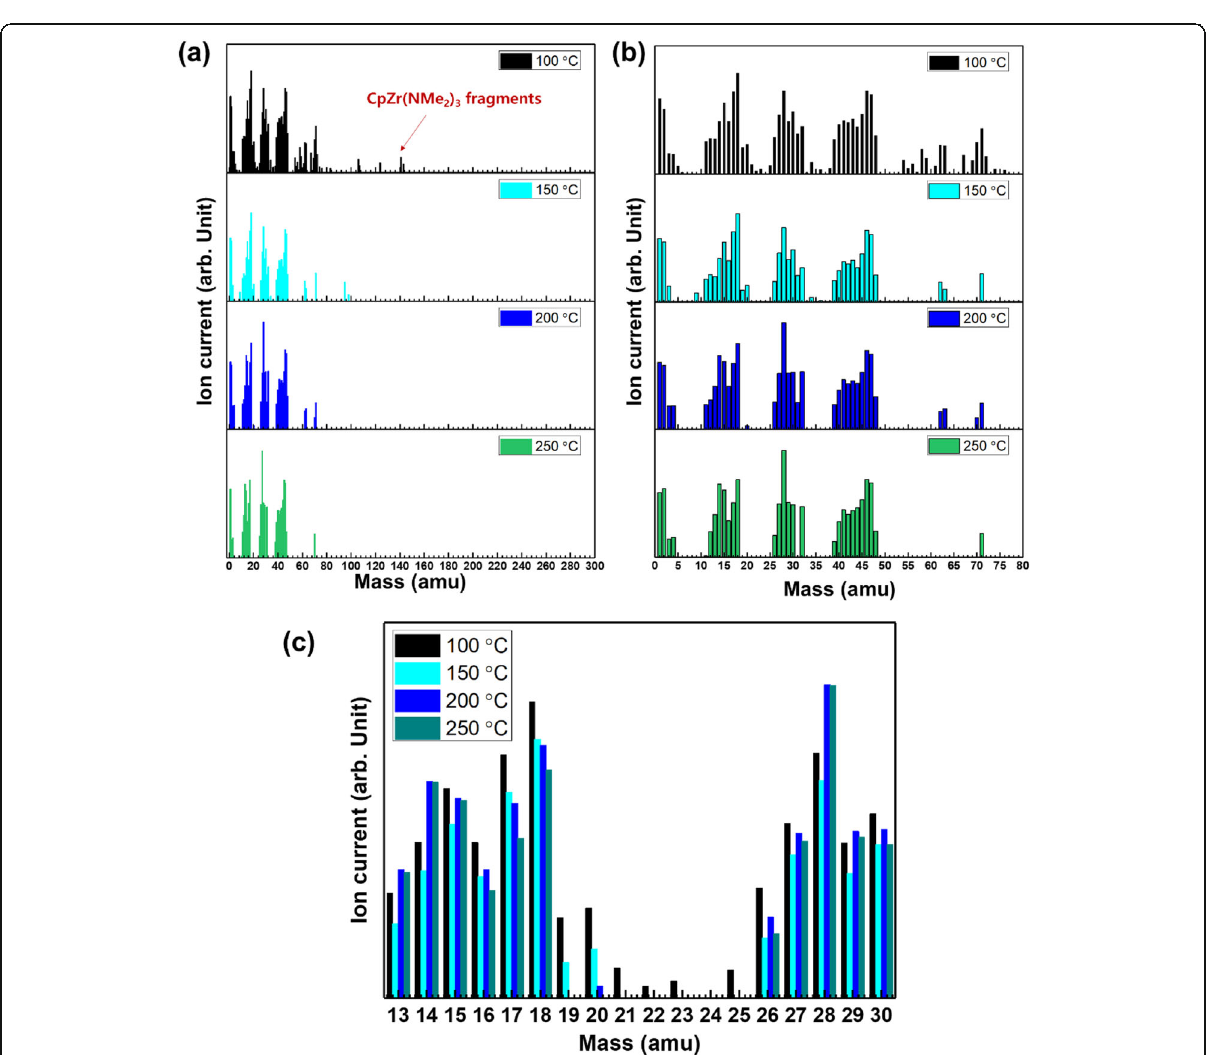
Fig. 4 QMS analysis data of CpZr(NMe 2 ) 3 a 0 to 300 amu, b 0 to 80 amu, and c 13 to 30